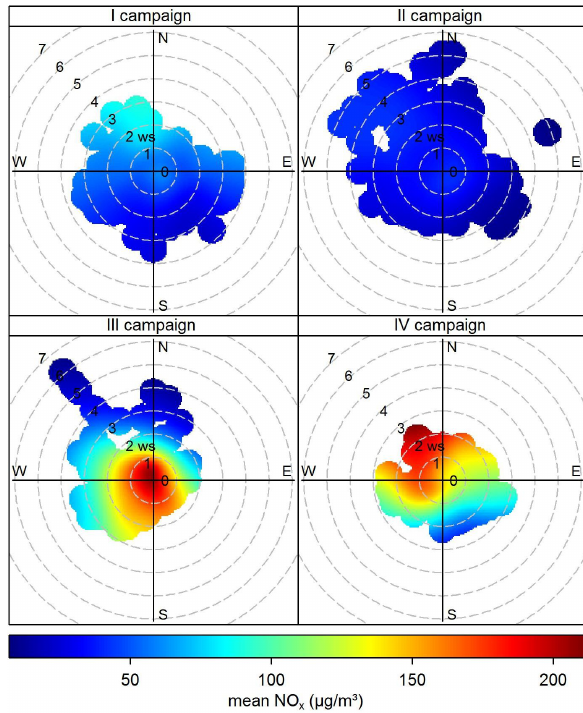
Figure 11: Monza, Viale della Libertà. Ex-ante measuring campaign. Polar plot showing the NOx mean concentrations variability by wind speed and direction. For each polar plot, the radial dimension is an indicator of wind speed (m/s). Further away from the center of the plot, the wind speed is higher